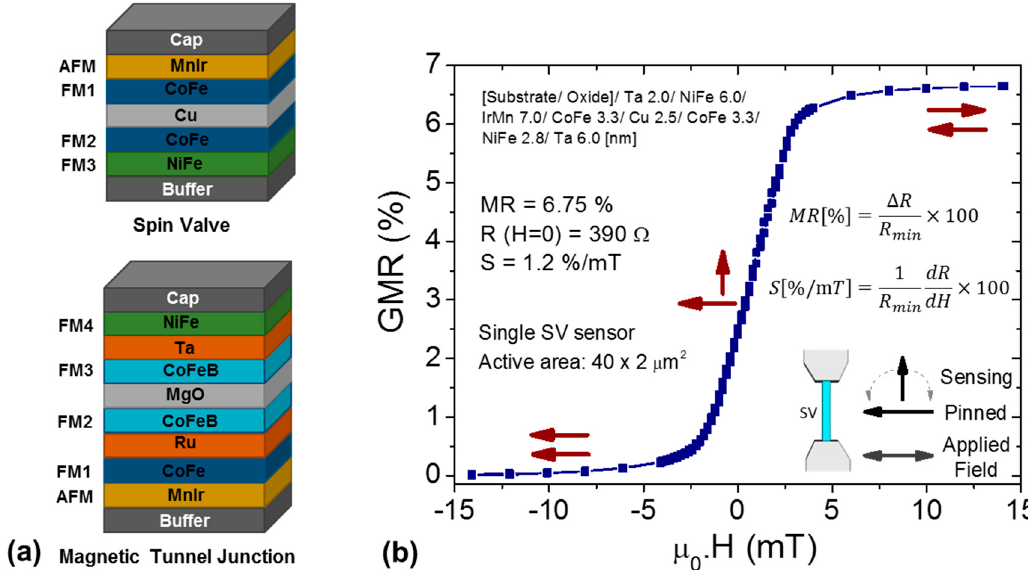
Figure 1. ( a ) Schematic view of a typical multilayer for spin-valves (SV) and magnetic tunnel junction (MTJ) sensors. SV: antiferromagnet (AFM), pinned layer (FM1), conductive spacer (Cu), sensing layer (FM2 and FM3). MTJ: antiferromagnet (AFM), pinned layer (FM1), insulator spacer (MgO), sensing layer (FM3 and FM4); a synthetic antiferromagnet (SAF) is obtained with the tri-layer FM1/Ru/FM2. The pinned layer magnetization is set in a fixed direction due to exchange-bias at AFM/FM interface; ( b ) Representative magnetotransport curve obtained for a patterned SV sensor (active area: 40 × 2 μ m 2 ) exhibiting a linear, centered and hysteresis free response. Red arrows illustrate the relative orientation of the in-plane magnetization in both pinned and sensing layers. S stands for the sensor sensitivity.